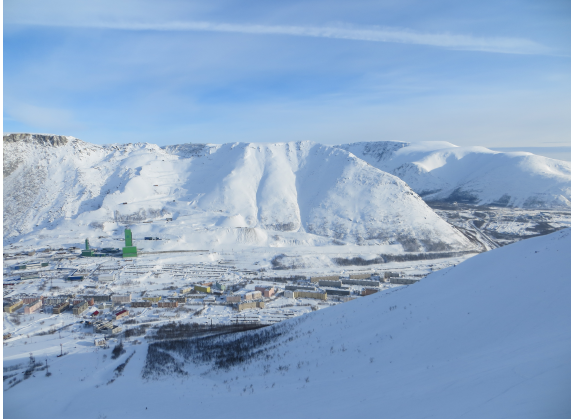
Figure 10. Mountain slopes in